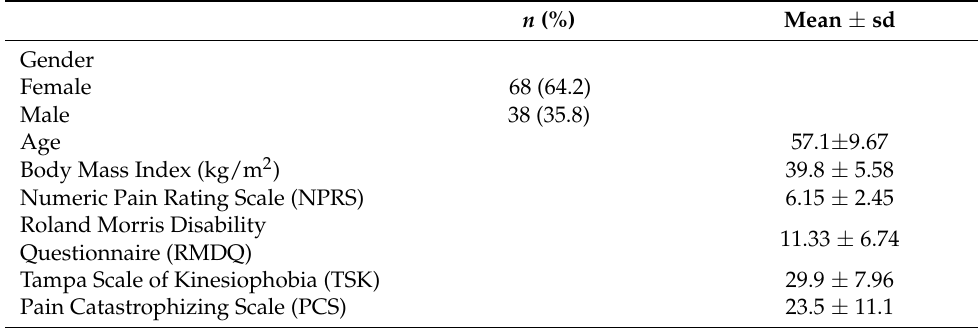
Table 1. Demographic and clinical characteristics of the sample ( n = 106)